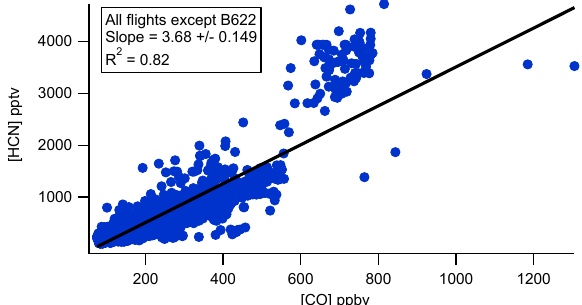
Fig. 8. HCN:CO correlations within BB plumes from the BOR- TAS campaign as determined using the 6-sigma HCN approach. Flight B622 data have been excluded due to the possible two sepa- rate slopes